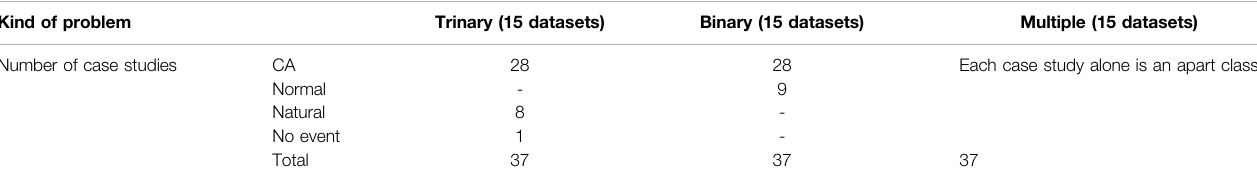
TABLE 1 | Problem kinds and case studies.